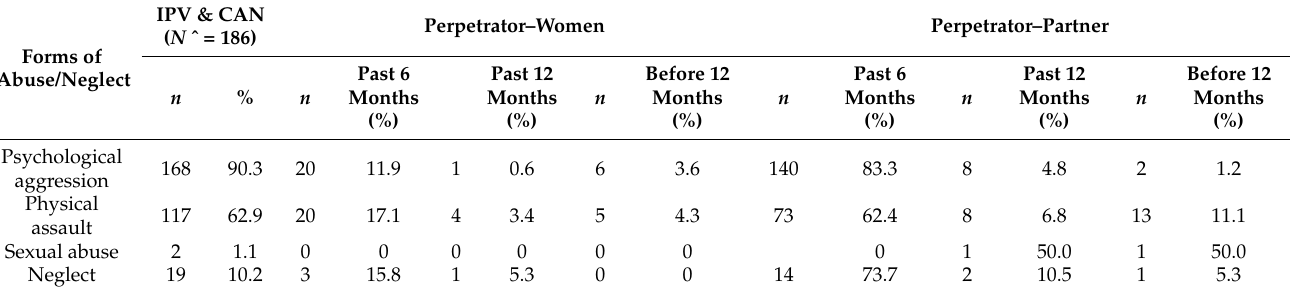
Table 4. Abuse and Neglect against Children.